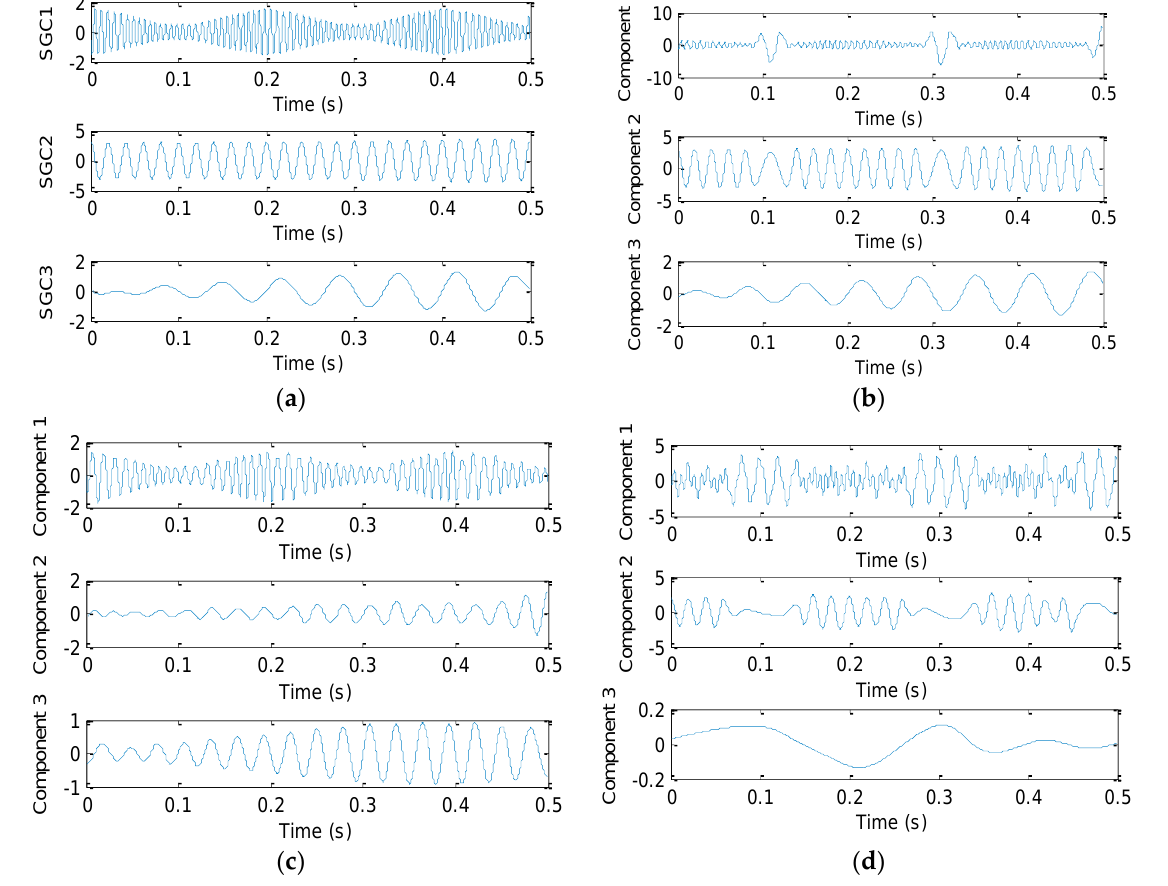
Figure 2. Decomposition results obtained by different methods: ( a ) symplectic geometry mode decomposition (SGMD), ( b ) ensemble empirical mode decomposition (EEMD), ( c ) empirical wavelet transform (EWT) and ( d ) ensemble intrinsic time-scale decomposition (EITD).